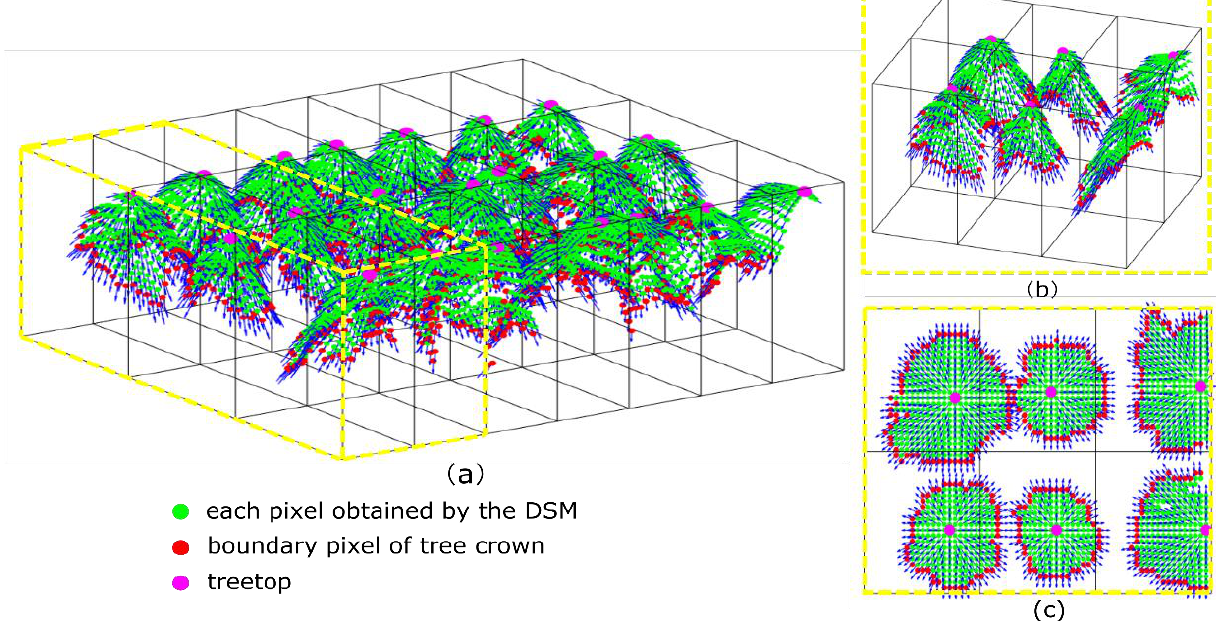
Figure 5. Schematic diagram showing the individual tree crown segmentation for the point clouds in the 21 adjacent voxels based on height-related gradient information. The black cuboid represents the segmented voxel classified as a tree by the PointNet. ( b , c ) are the side and top views of the zoomed area of the yellow cuboid shown in figure ( a ), respectively.